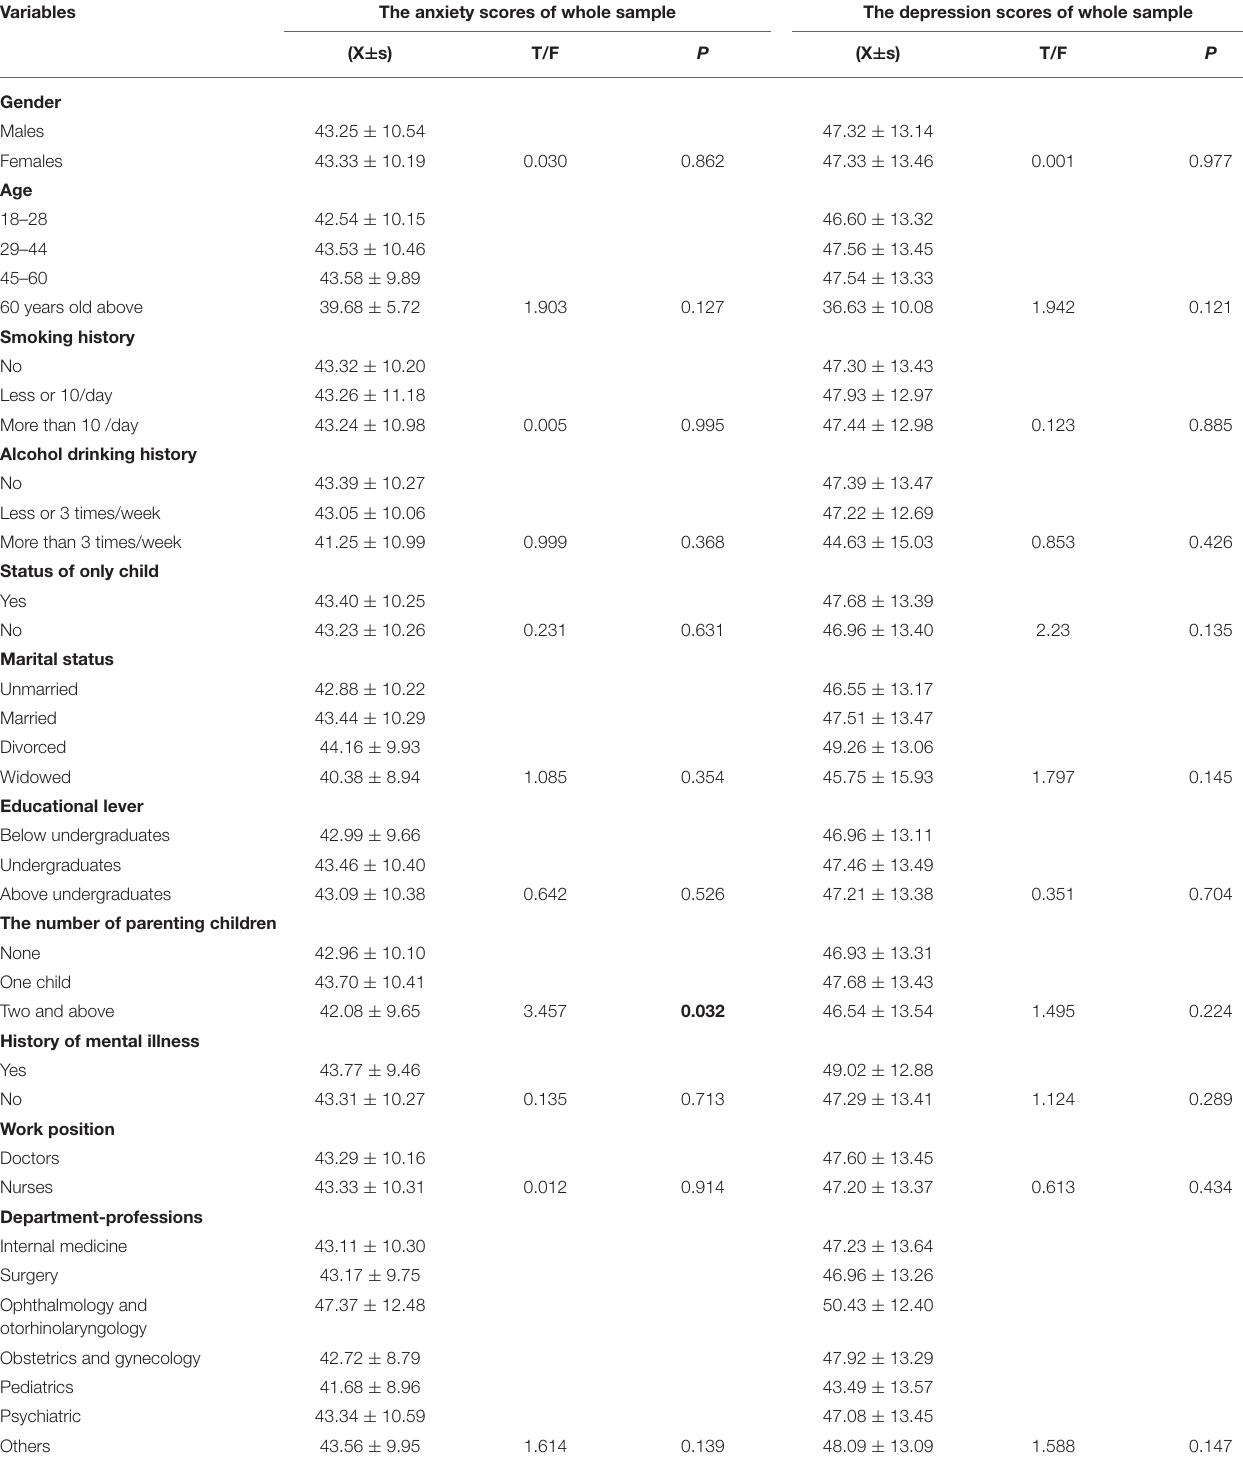
TABLE 3 | Single-factor analysis of potential factors and anxiety/depression scale scores. Variables The anxiety scores of whole